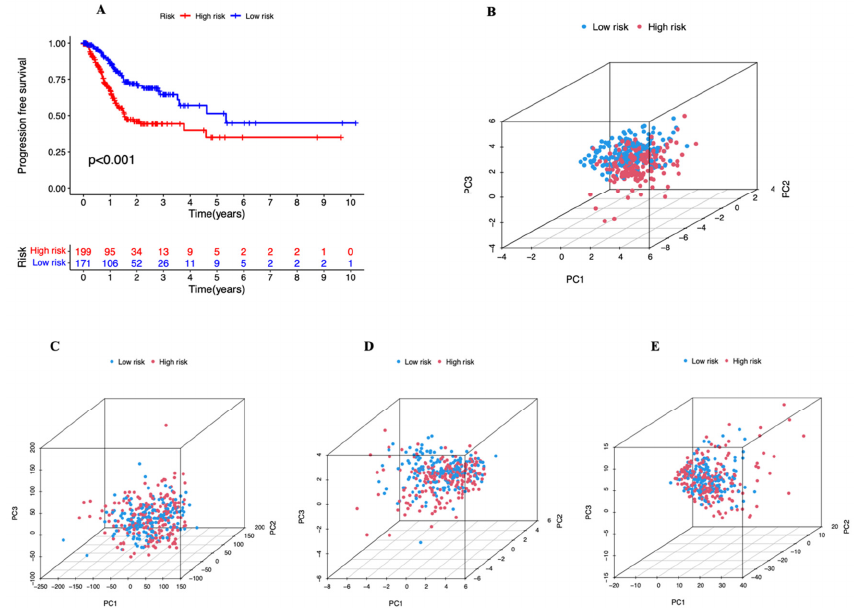
Figure 6. ( A ) Kaplan–Meier curves of progression-free survival (PFS) in STAD patients. ( B – E ) PCA in both groups of patients. ( B ) PCA of six risk lncRNAs in the prognostic marker. ( C ) PCA of all genes. ( D ) Twenty-two cuproptosis-related genes. ( E ) Sixteen cuproptosis-related lncRNAs. PCA, principal component analysis.